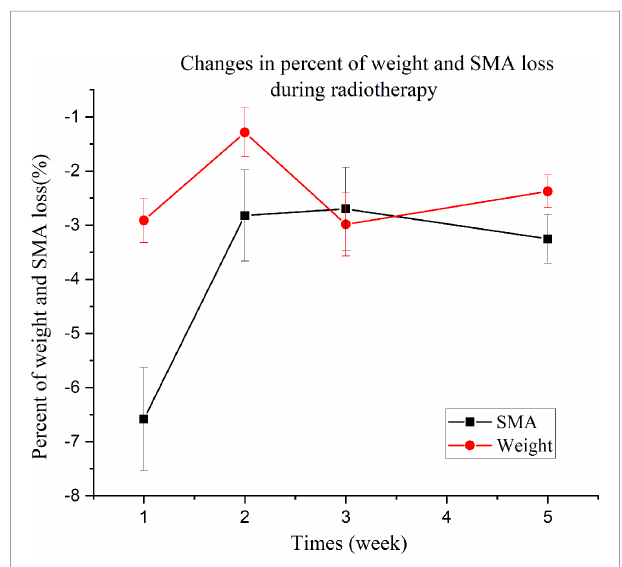
FIGURE 6 | Percentage changes in weight and skeletal muscle area loss during